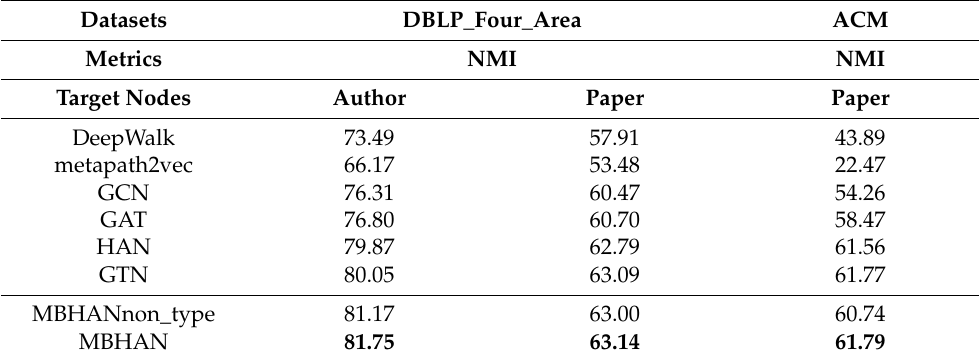
Table 4. Node clustering performance results